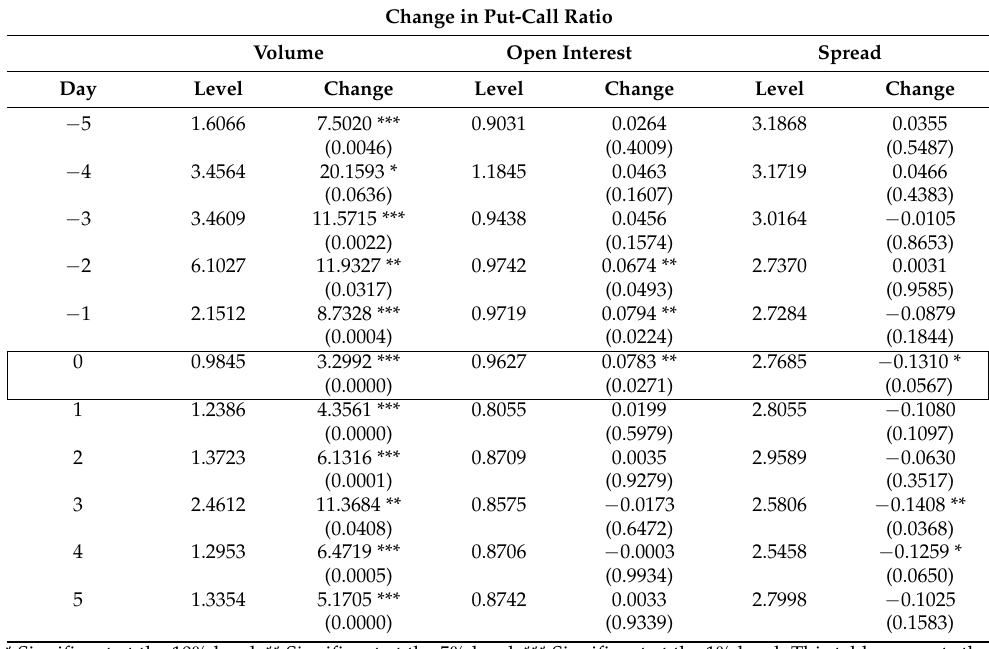
Table 3. Put–call ratios around SEO pricing. Change in Put-Call Ratio Volume Open Interest